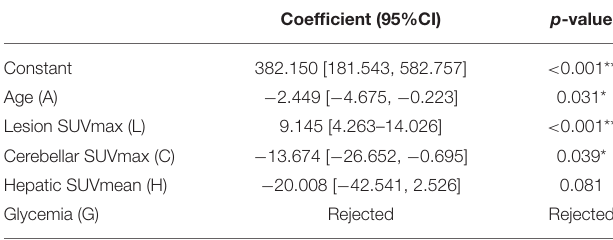
TABLE 1 | Patients’ characteristics. TABLE 2 | ANOVA analysis and derived model for TMTV